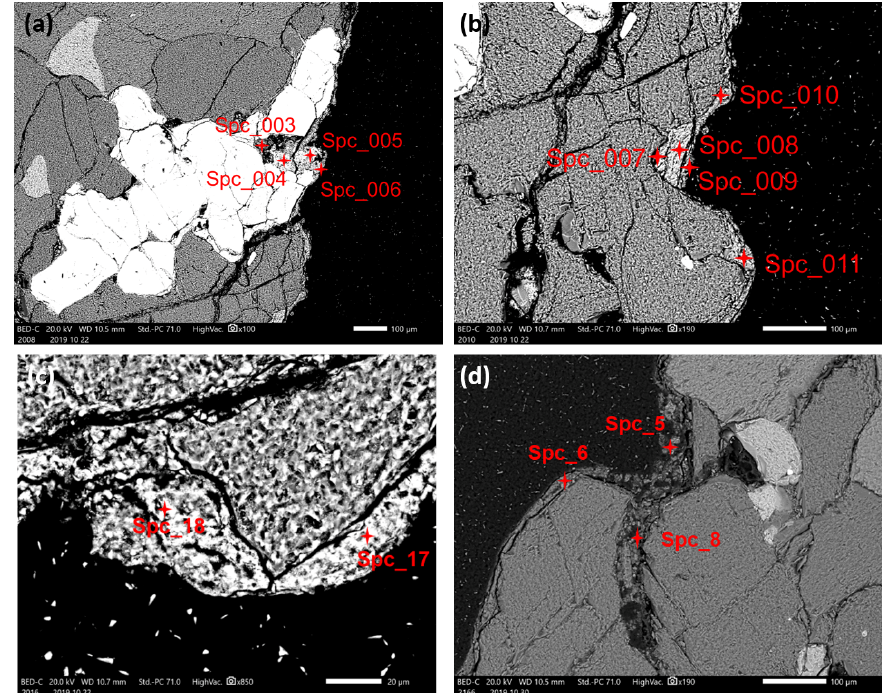
Figure 3. ( a ) Backscattered electron images in SEM showing the iron inclusion in rock sample 1 as white reveal a continuous inorganic coating; ( b ) site indications of EDS analyses of coatings on sample 1; ( c ) site indications of EDS analyses of coatings on sample 1; ( d ) backscattered electron images in SEM of sample 2 with inorganic coating and sites of EDS analyses.